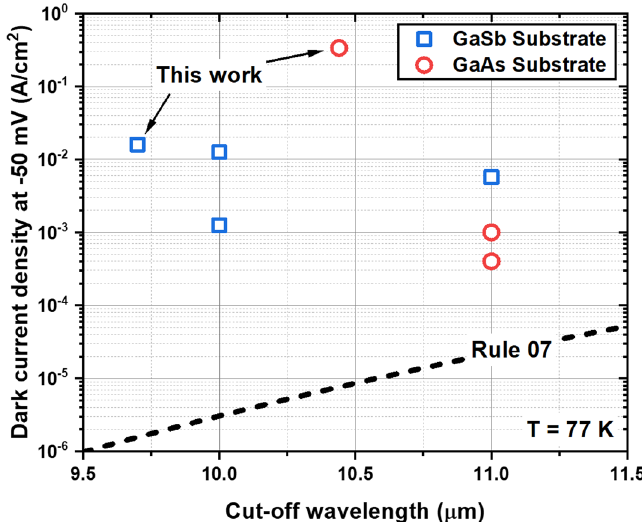
Figure 7. The dark current density at −50 mV of Samples C and D compared to a sampling of previously reported LWIR InAs/GaSb T2SL p-i-n diodes and the Rule